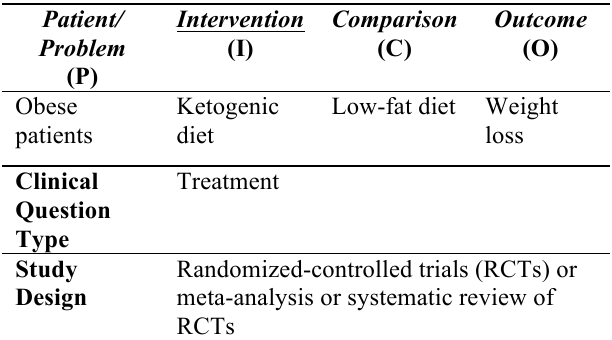
Table 1. Clinical questions formula Patient/